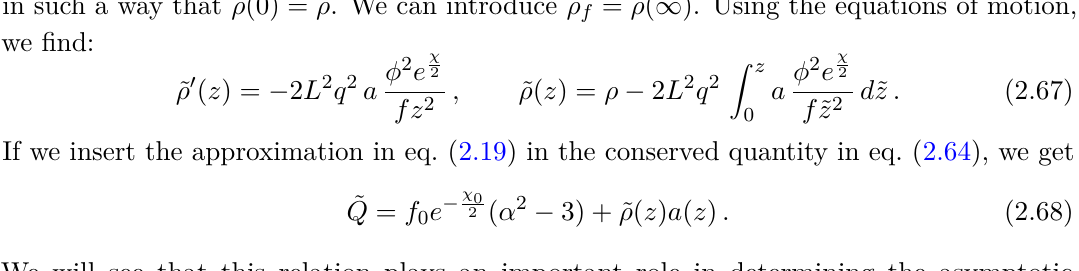
JHEP08(2022)235